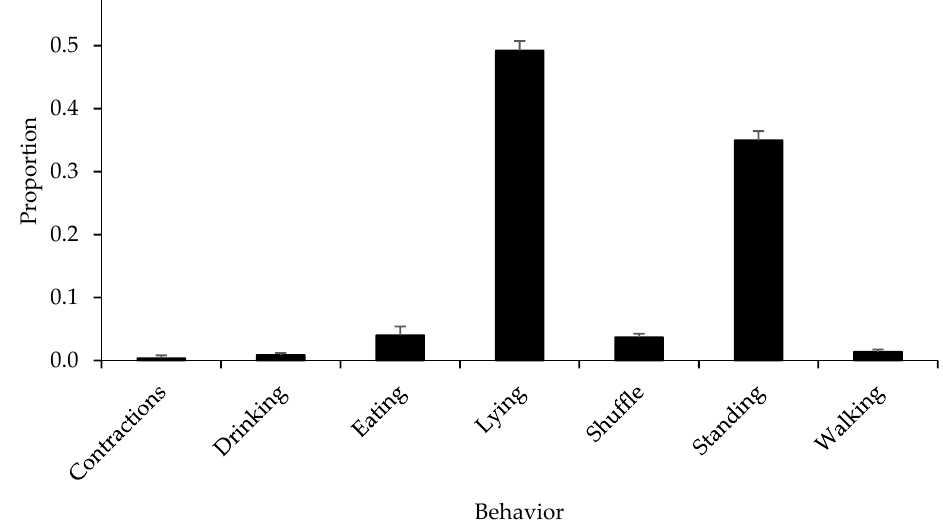
Figure 1. Predicted mean ( ± SEM) proportion of time dairy cows ( n = 35) spent doing different behaviors during the 9 h prior to calving. Table 1. Effects of parity, time period and calving assistance on the duration of dairy cow ( n = 35) behaviors as a proportion of time.